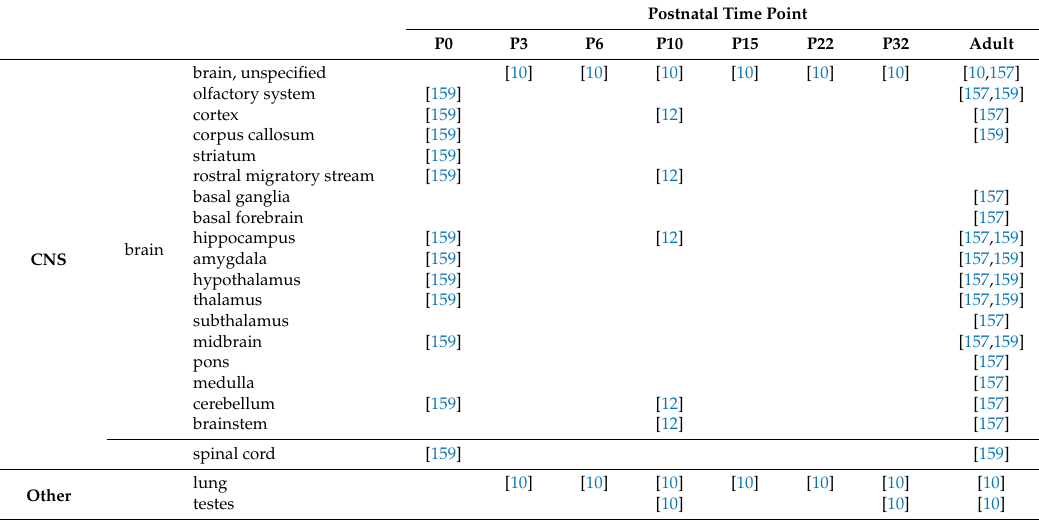
Table 7. Studies of TUBA1A expression in postnatal